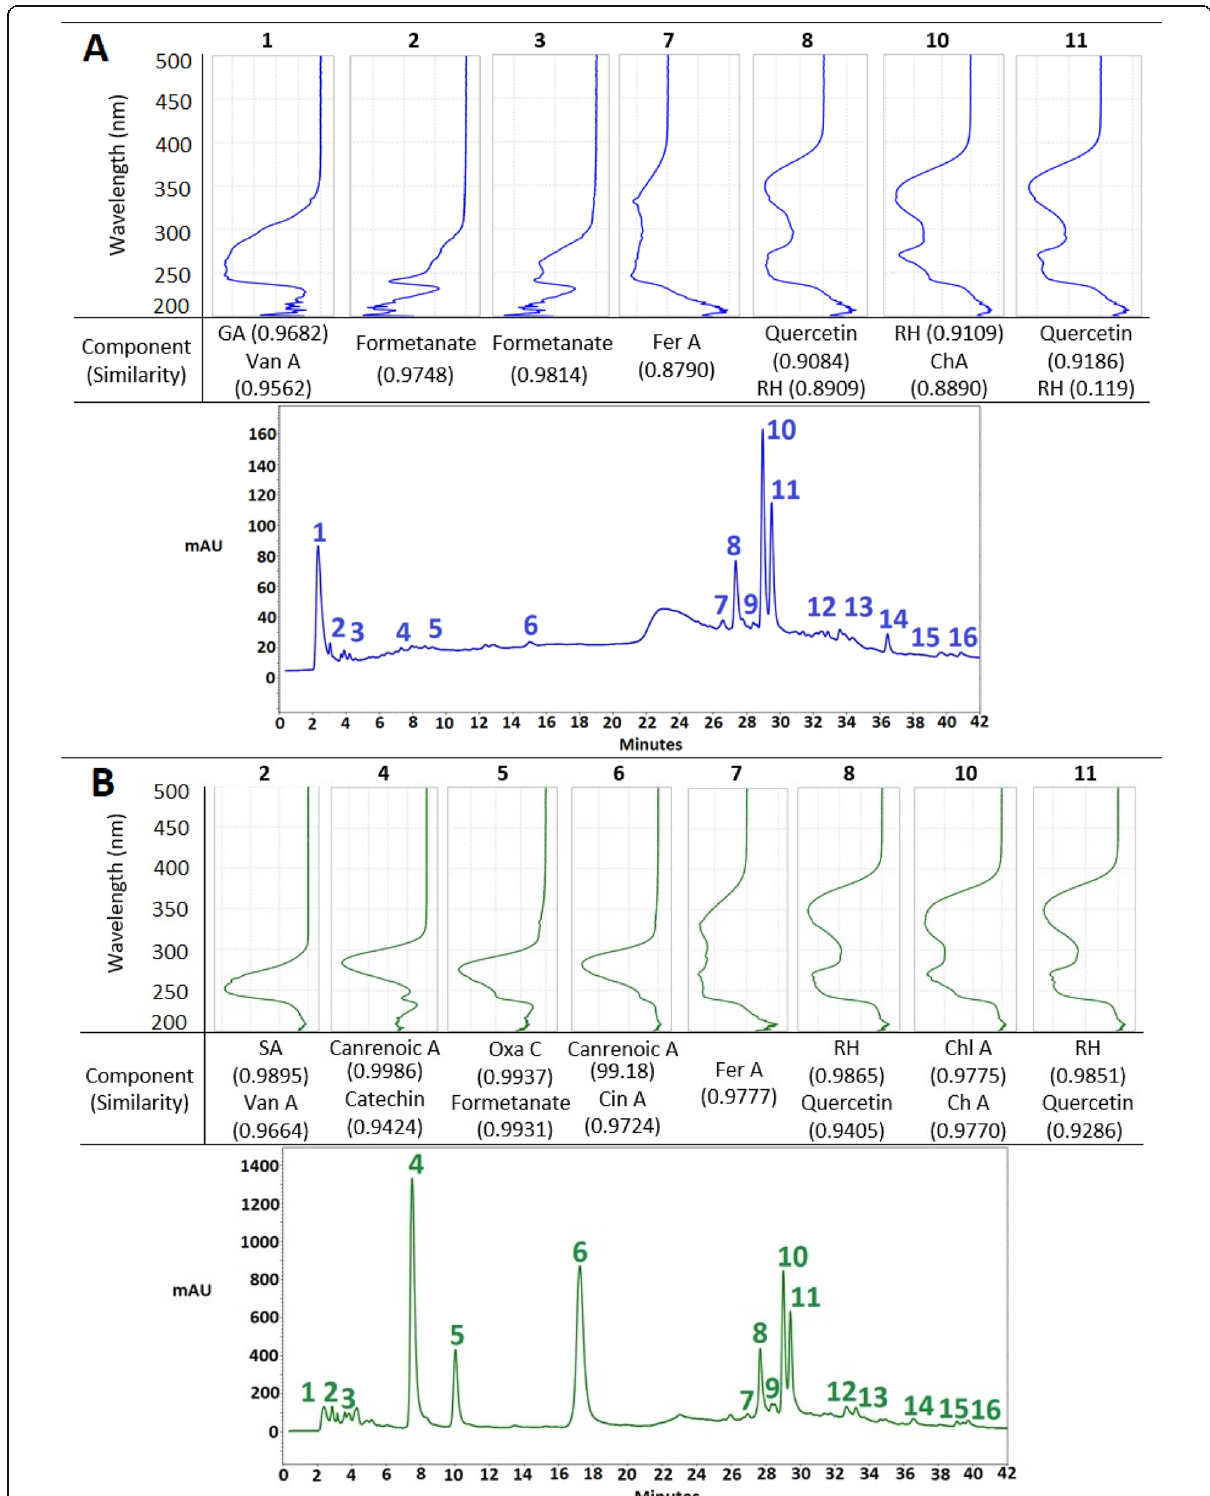
Fig. 1 (See legend on next